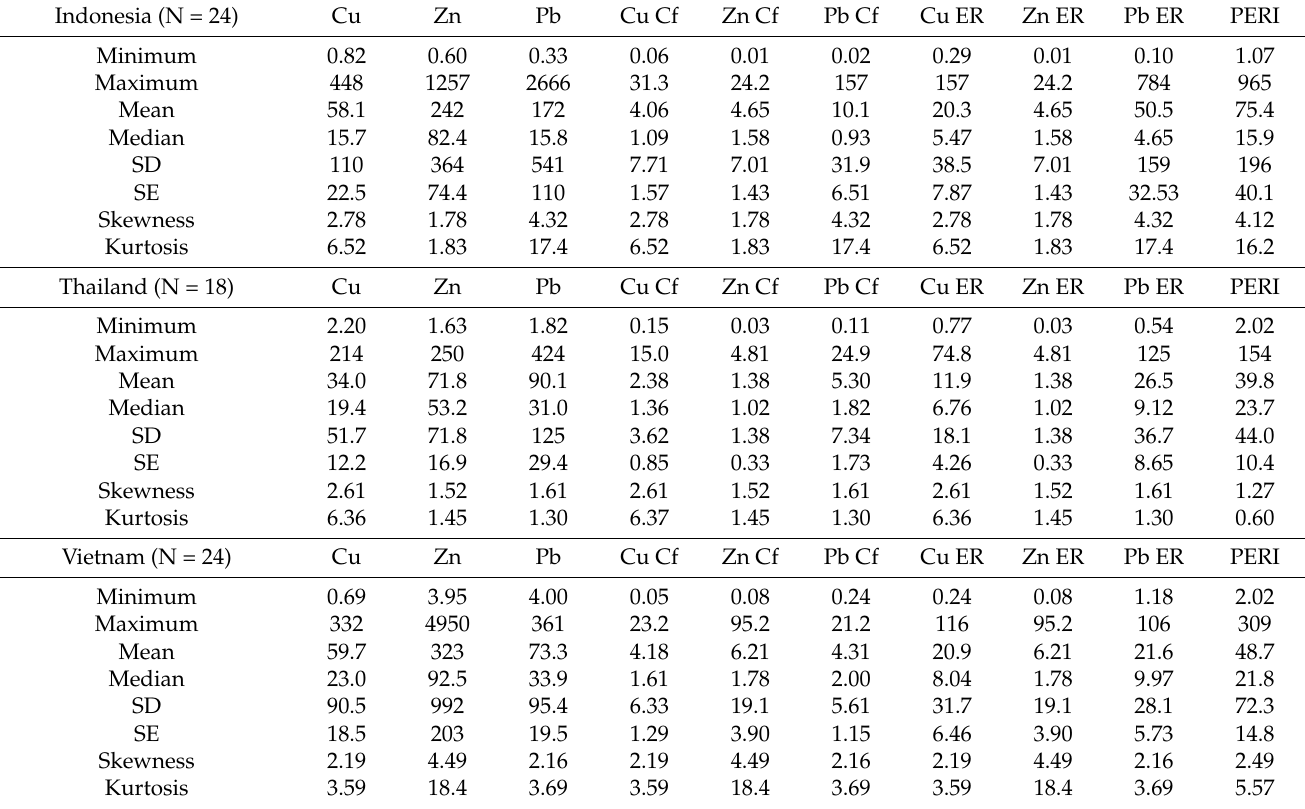
Table 4. Overall statistics of values of concentrations (mg/kg dry weight) of Cu, Zn, and Pb, and their concentration factors (Cf) and ecological risks (ER) from the present